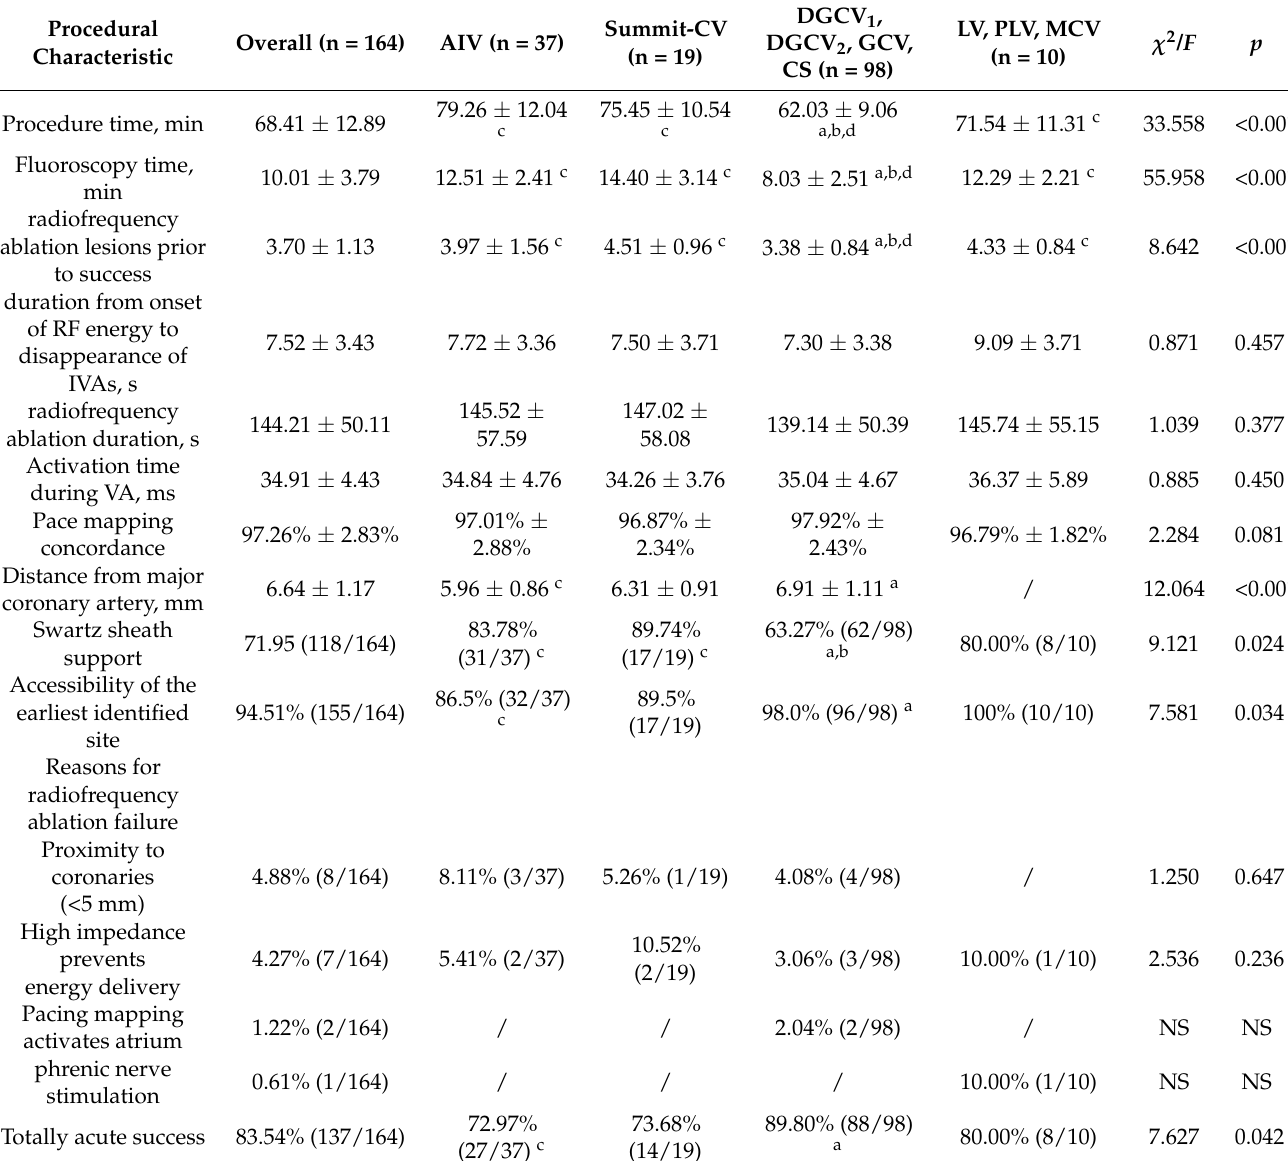
Table 2. Procedural